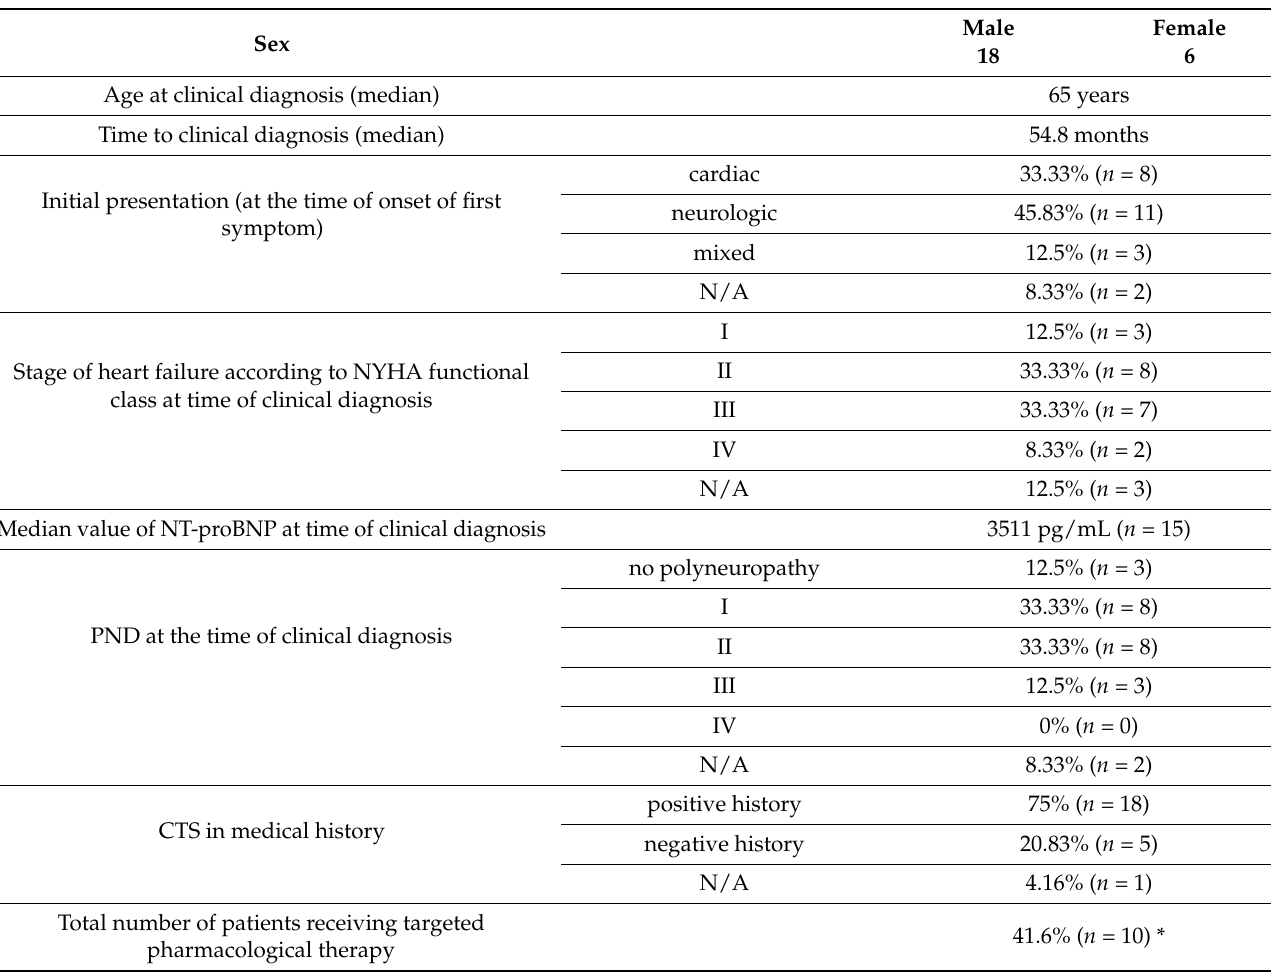
Table 1. Clinical characteristics of patients with symptomatic ATTRv ( n = 24).